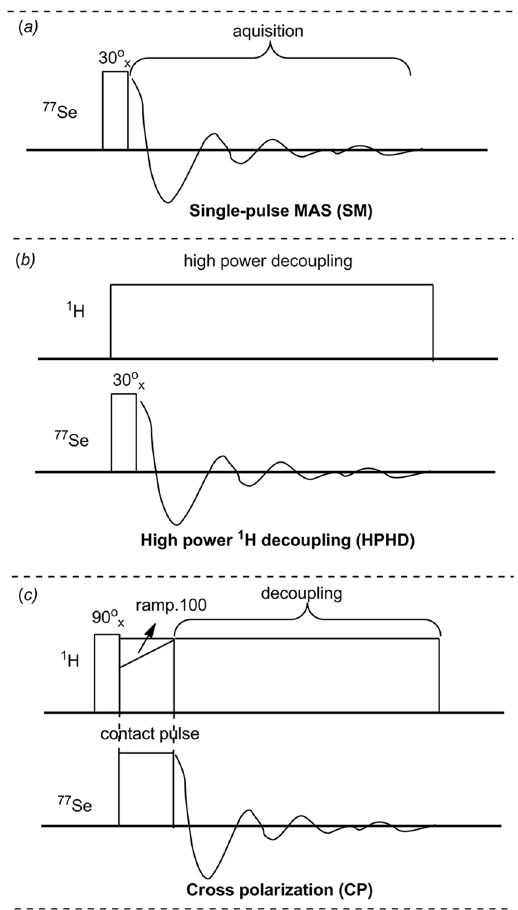
Figure 8. Schematic illustration of different pulse sequences. ( a ) Single pulse (SP); ( b ) High power 1 H decoupling (HPHD); ( c ) Cross polarization